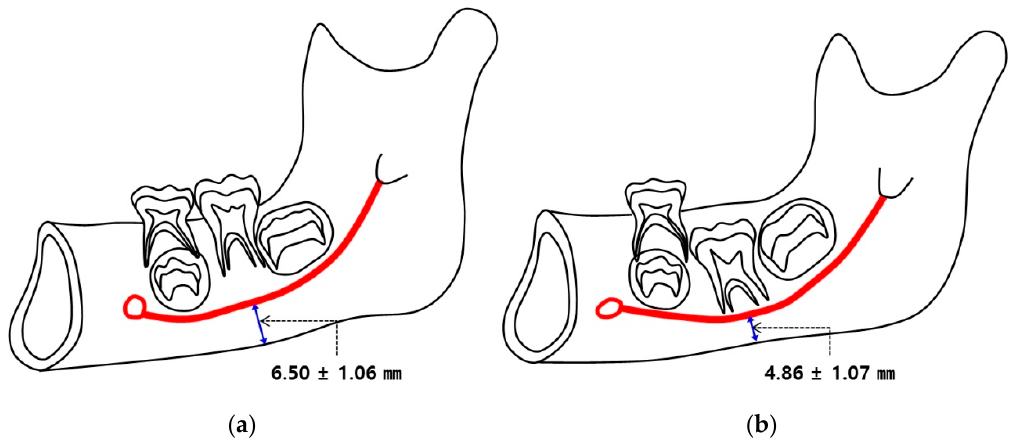
Figure 6. Schematic drawings displaying results of this study. The mandibular canal tends to be positioned more inferiorly in relation to permanent mandibular first molars with eruption disturbances than with normal eruption. ( a ) mean value of the distance from the most inferior margin of mandible to center of mandibular canal (M–C) in normal group; ( b ) mean value of the distance from the most inferior margin of mandible to center of mandibular canal (M–C) in eruption disturbance (ED)